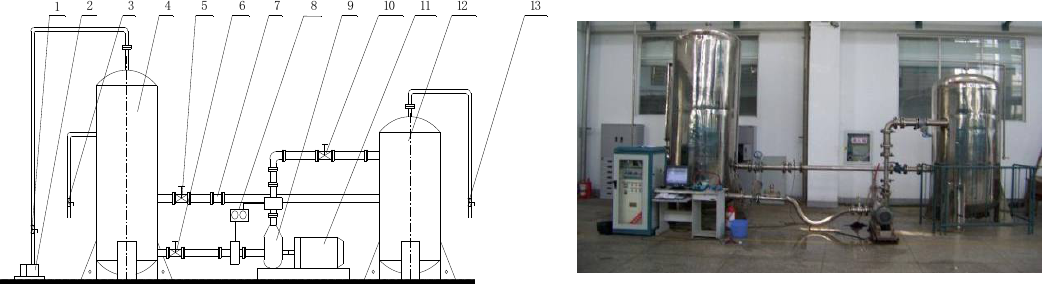
Figure 1. Schematic of the experimental rig for operation simulation of centrifugal pump. 1, 3, 13. Ball valve; 2. Vacuum pump; 4. Cavitation tank; 5, 10. Butterfly valve; 6. Gate valve; 7. Electromagnetic flowmeter; 8. Pressure transmitter; 9. Model pump; 11. Motor; 12. Stable flow tank.